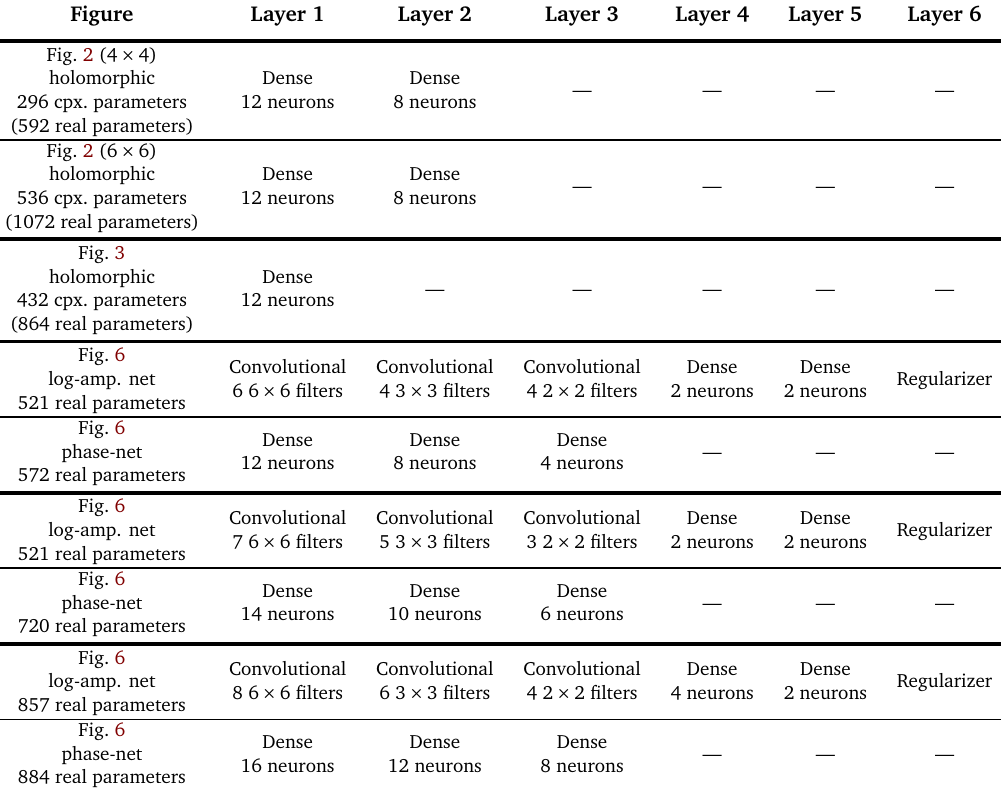
Table 1: Neural network architectures used for the numerical simulations shown throughout the